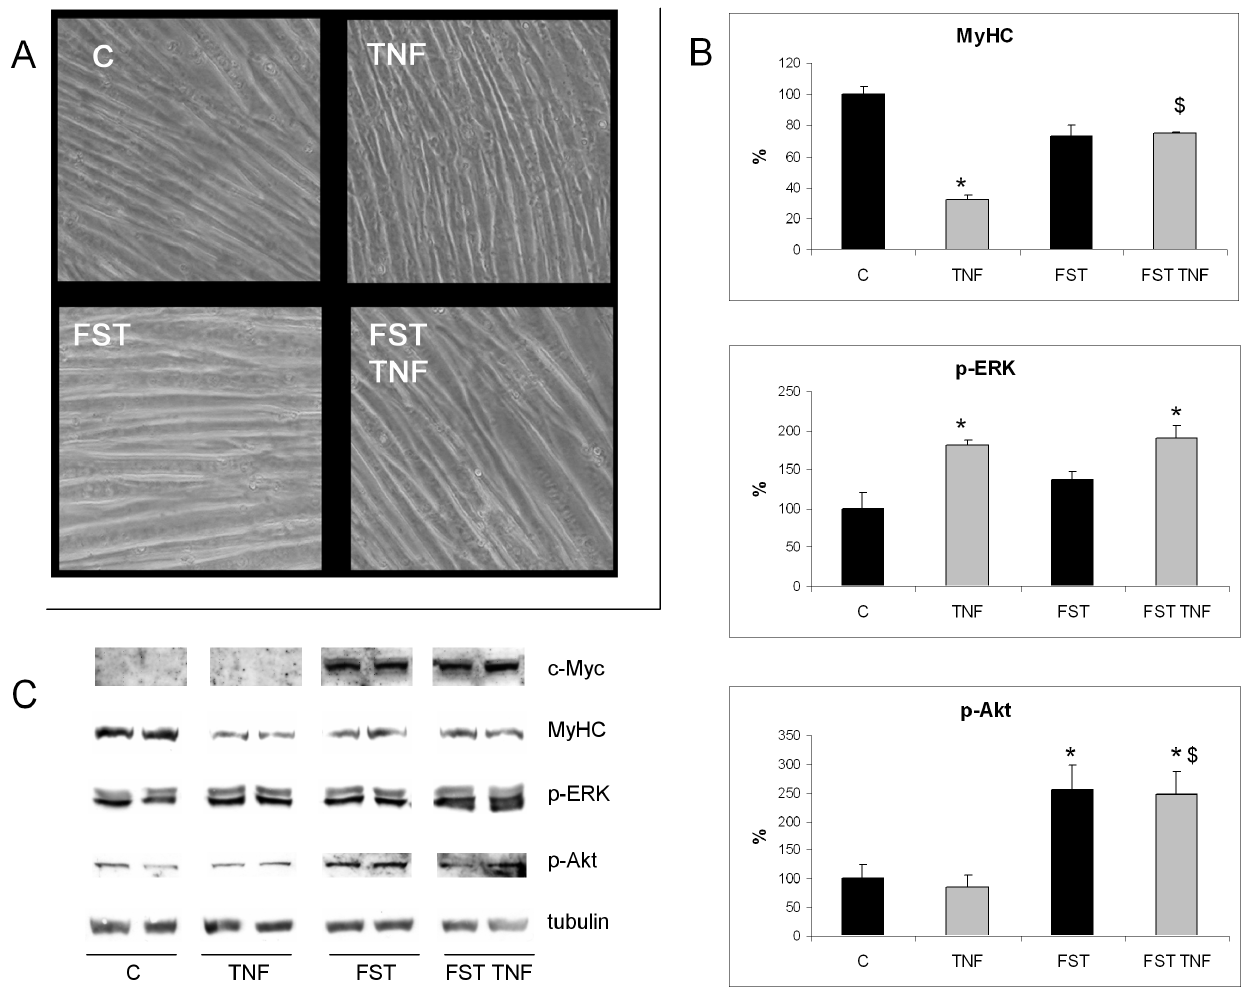
Figure 4. Follistatin overexpression prevents TNF a -induced MyHC loss without interfering with ERK activation. C2C12 myotubes (5 days differentiation), transfected or not with myc-follistatin (FST) and treated or not with 100 ng/ml TNF a for 48 h. (A) Phase contrast microscopy showing the hypertrophy induced by FST in cells treated or not with TNF a . (B) Western blots for MyHC, p-ERK and p-Akt protein levels and (C) corresponding densitometric analysis normalized by tubulin. Data (means 6 SD; n=3) expressed as percentage of controls. Significance of the differences: *p , 0.05 vs C; $ p , 0.05 vs TNF a .